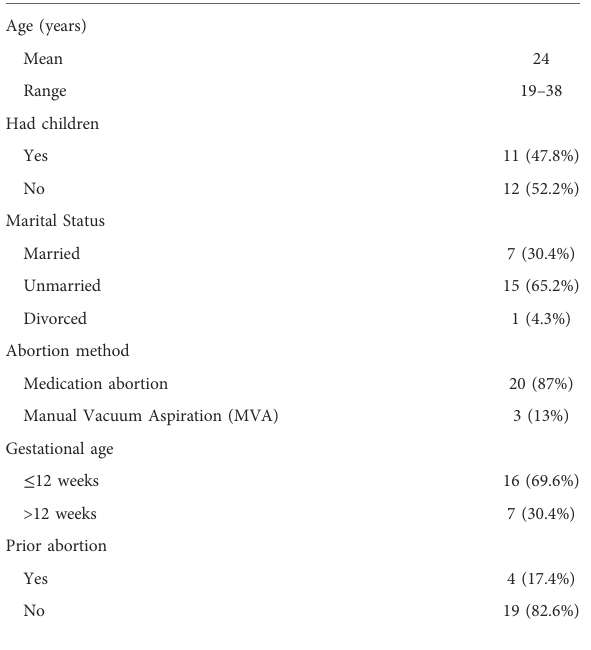
TABLE 1 Participant